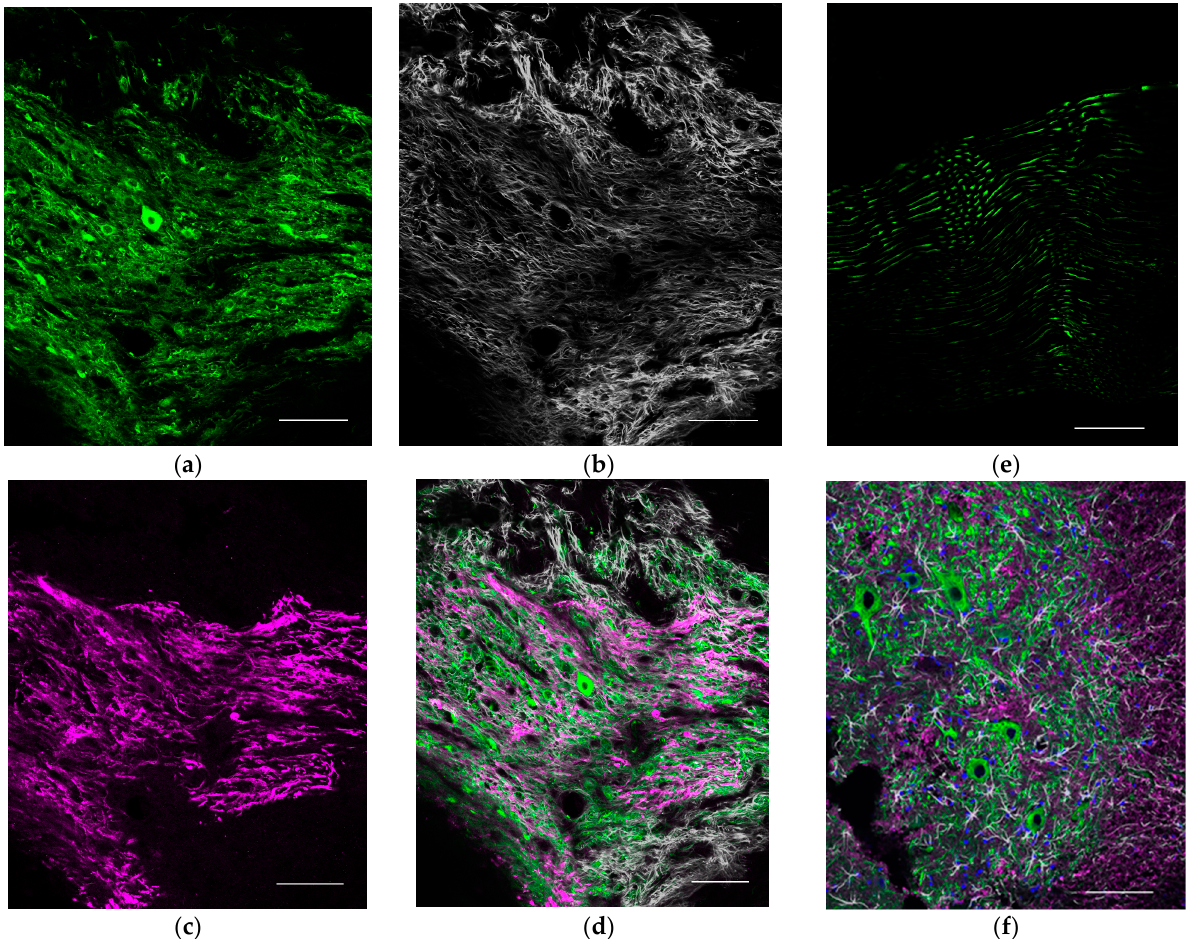
Figure 2. Immuno-histological evaluation at the transected distal peripheral nerve with transplanted cells compared to the naive nerve and spine (sagittal section). ( a ) Tuj1 ( β 3 tubulin) staining. ( b ) GFAP (glial fibrillary acidic protein) staining. ( c ) MBP (myelin basic protein) staining. ( d ) Tuj1/GFAP/MBP staining. ( e ) Tuj1 staining in the intact peripheral nerve without transplantation. ( f ) Tuj1/GFAP/MBP staining at the anterior horn of the spinal cord. Scale bar = 100 μ m.